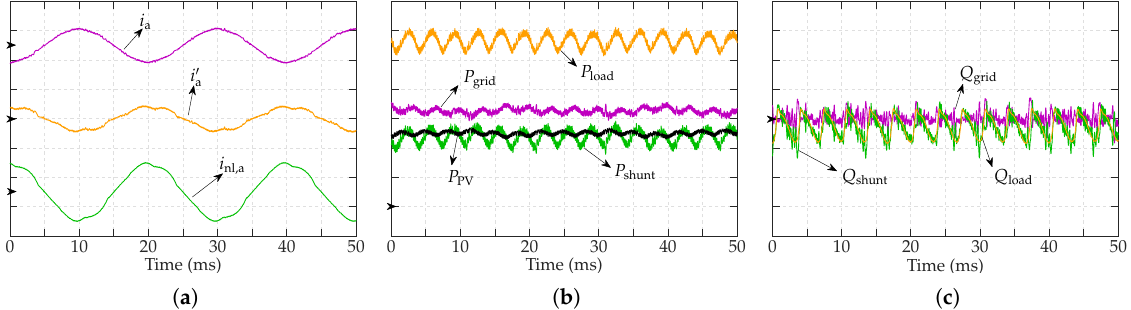
Figure 10. Simulation results with a 2kW resistive load and 250W non-linear load. ( a ) Grid line current i a , shunt converter ac line current i 0 a and load line current i nl,a [10A/div]. ( b ) Instantaneous active power flow